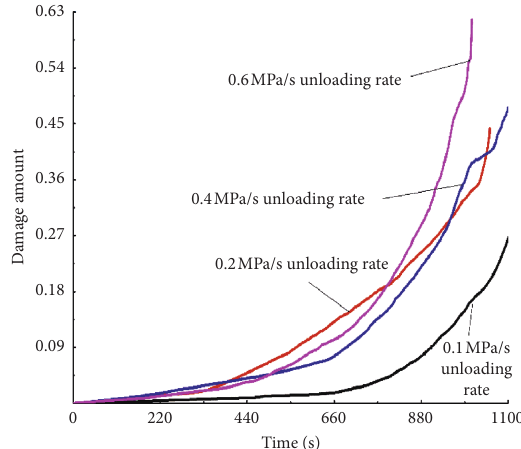
Figure 13: Corresponding curves of damage strain under different strain rates.